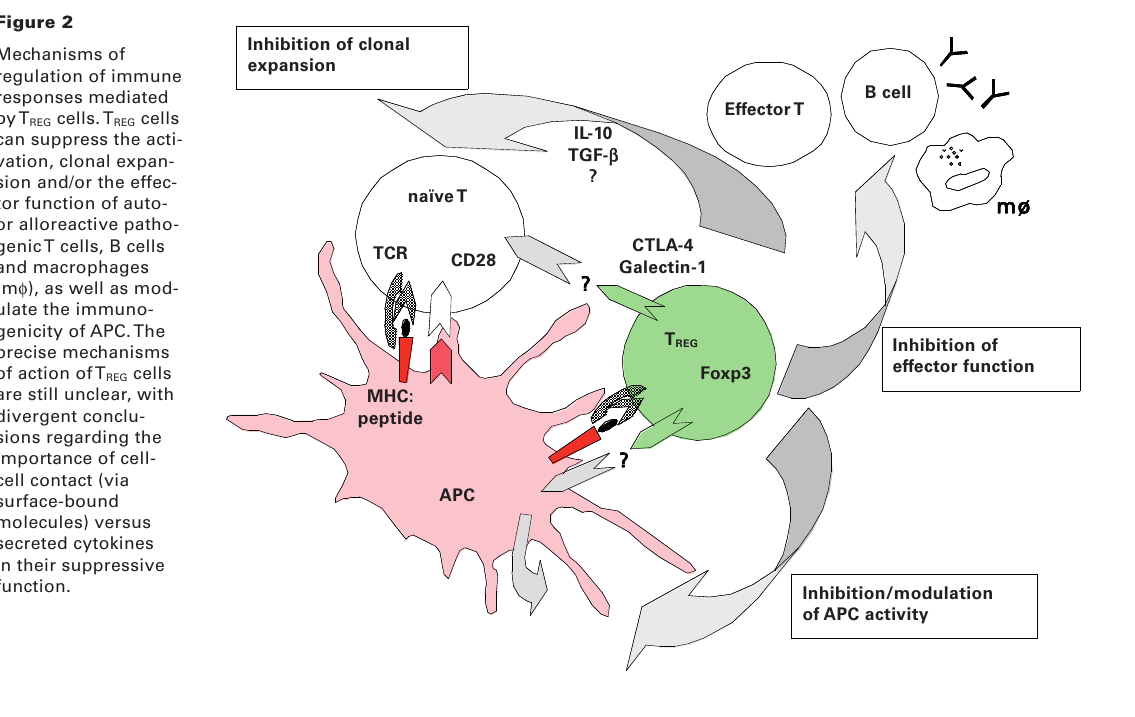
Figure 2 Mechanisms of regulation of immune responses mediated by T REG cells. T REG cells can suppress the acti- vation, clonal expan- sion and/or the effec- tor function of auto- or alloreactive patho- genic T cells, B cells and macrophages (m f ), as well as mod- ulate the immuno- genicity of APC. The precise mechanisms of action of T REG cells are still unclear, with divergent conclu- sions regarding the importance of cell- cell contact (via surface-bound molecules) versus secreted cytokines in their suppressive